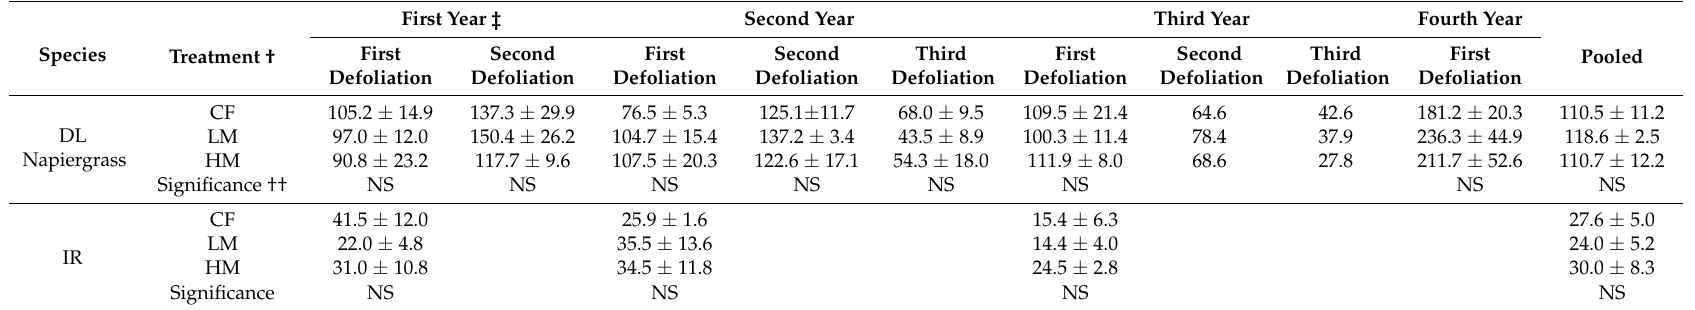
Table 4. N uptake (g m − 2 ) by DL Napiergrass and IR under different fertilizer treatments in